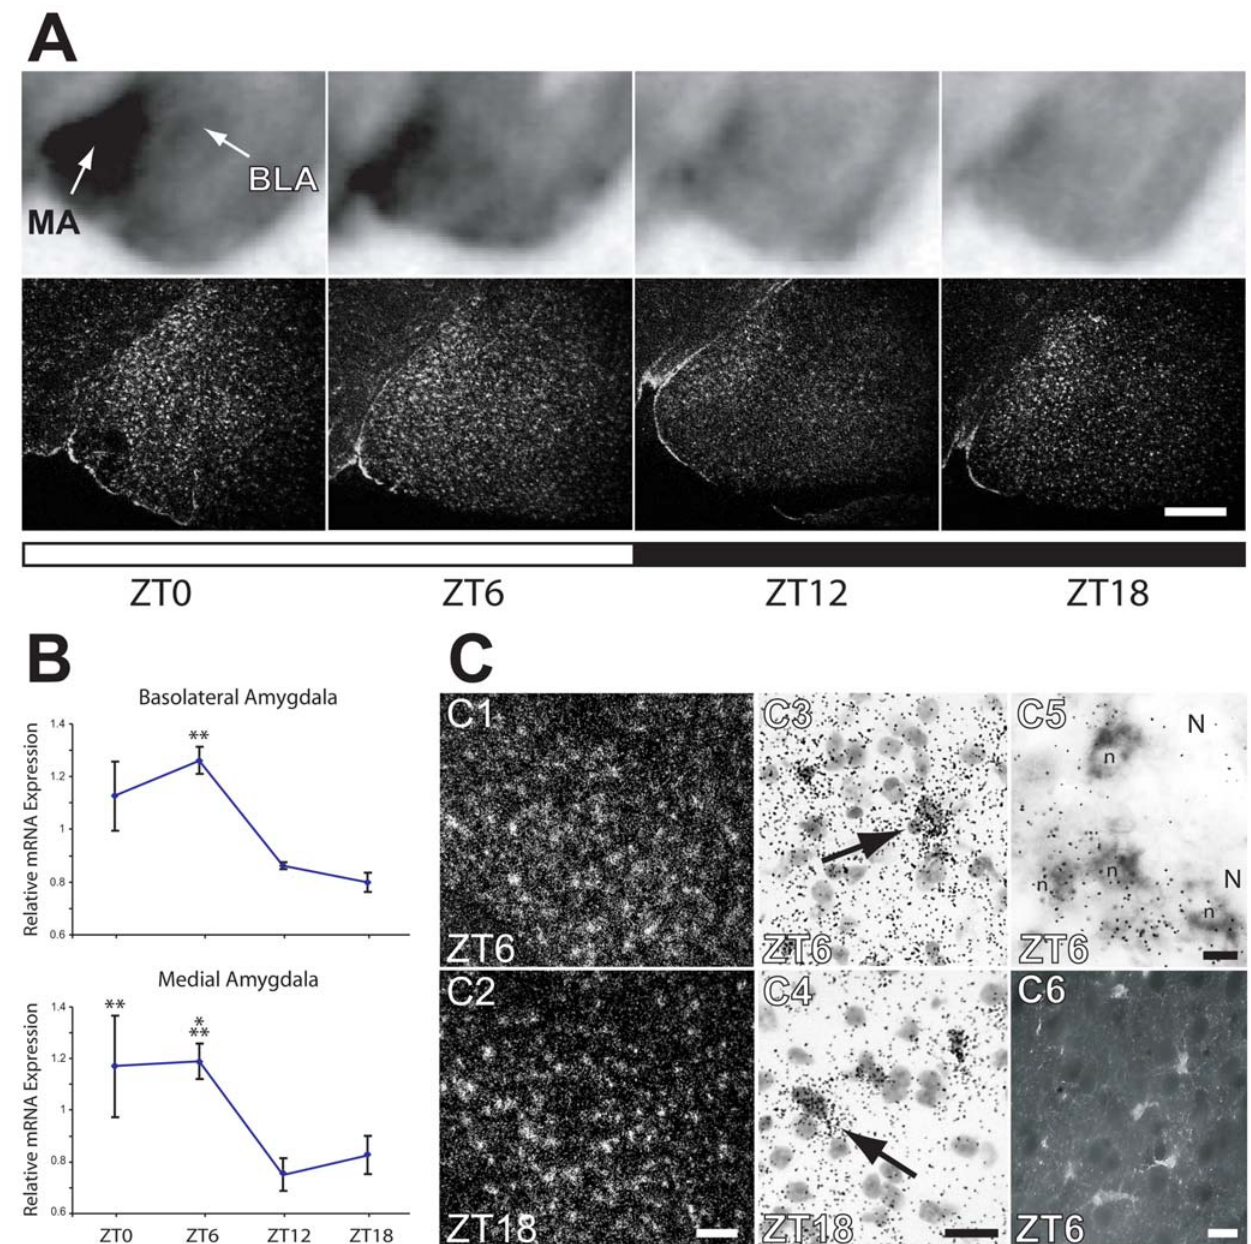
Figure 4. The amount and distribution of Fabp7 mRNA in amygdala changes during the diurnal cycle. A) In situ hybridization of coronal tissue sections probed for Fabp7 mRNA at four diurnal time points. Top panels, phosphorimages of amygdala, bottom panels, dark field images of a different set of hybridized sections subjected to emulsion autoradiography. Higher levels of Fabp7 were evident during lights-on. B) Graphic representation of elevated Fabp7 mRNA levels during lights-on in basolateral and medial amygdala. Two-way ANOVA (p=0.002). ***p , 0.001, **p , 0.01 vs. ZT18 (post-hoc t-test). Each value represents the average + / 2 S.E.M. N =2–4 per time point. C) Sections processed for in situ hybridization for Fabp7 subjected to emulsion autoradiography. Dark field microscopy revealed a more dispersed labeling pattern at ZT 6 (C1) compared to ZT18 (C2). Higher magnification micrographs of Nissl counterstained sections indicated labeling over cells whose staining pattern was consistent with an astrocyte morphology and whose labeling pattern was more disperse at ZT6 (C3) compared to ZT18 (C4). Note that silver grain accumulation around cell nuclei was similar at the two time points (arrows in C3 and C4). Astrocytes stained with DIG-labeled riboprobe for Fabp7 (unstained astrocytic nuclei (n) are indicated) were also co-labeled for mRNA for the astrocyte protein, GFAP (silver grain accumulations). Unstained neuronal nuclei (N) are shown for reference. A representative tissue section subjected to immunohistochemistry with anti-Fabp7 antibodies is shown in C6. Note astrocytic processes emanating from stained cell somata. Bar in A=400 m m; in C1,C2=100 m m; in C3,C4=20 m m; in C5=10 m m, C6=30 m m BLA, basolateral amygdala; MA, medial amygdala